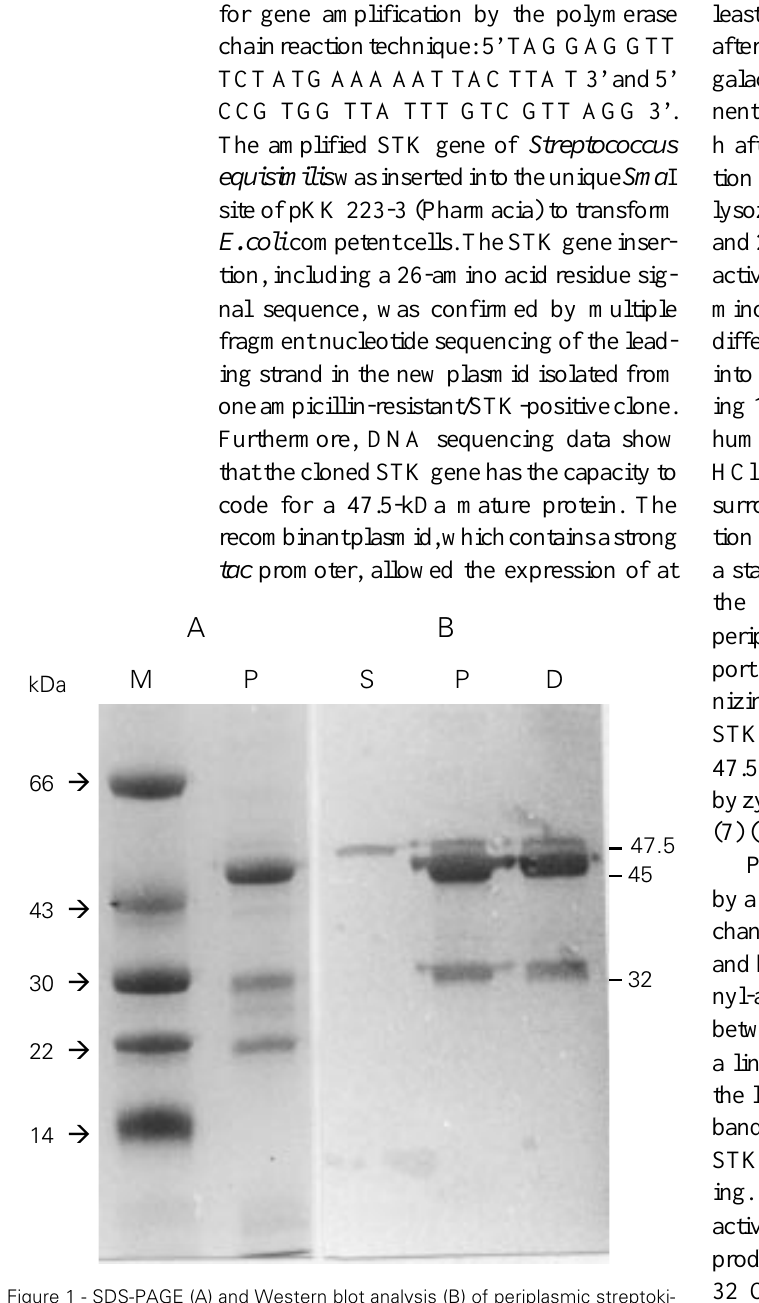
Figure 1 - SDS-PAGE (A) and Western blot analysis (B) of periplasmic streptoki- nase (STK). Periplasmic proteins were separated on a 0.1% SDS/15% polyacryl- amide gel and stained with Coomassie blue. A replica was blotted onto a nitrocellulose membrane and analyzed with an anti-STK rabbit polyclonal antise- rum developed against native STK. A , Lane M: molecular weight standards (serum albumin, 66 kDa; ovalbumin, 43 kDa; carbonic anhydrase, 30 kDa; soy- bean trypsin inhibitor, 22 kDa; lysozyme, 14 kDa); lane P: periplasmic proteins. B , Lane S: native STK; lane P: periplasmic proteins; lane D: “pool” of periplasmic proteins eluted from the DEAE Sepharose column with STK activity. The major forms of rSTK are